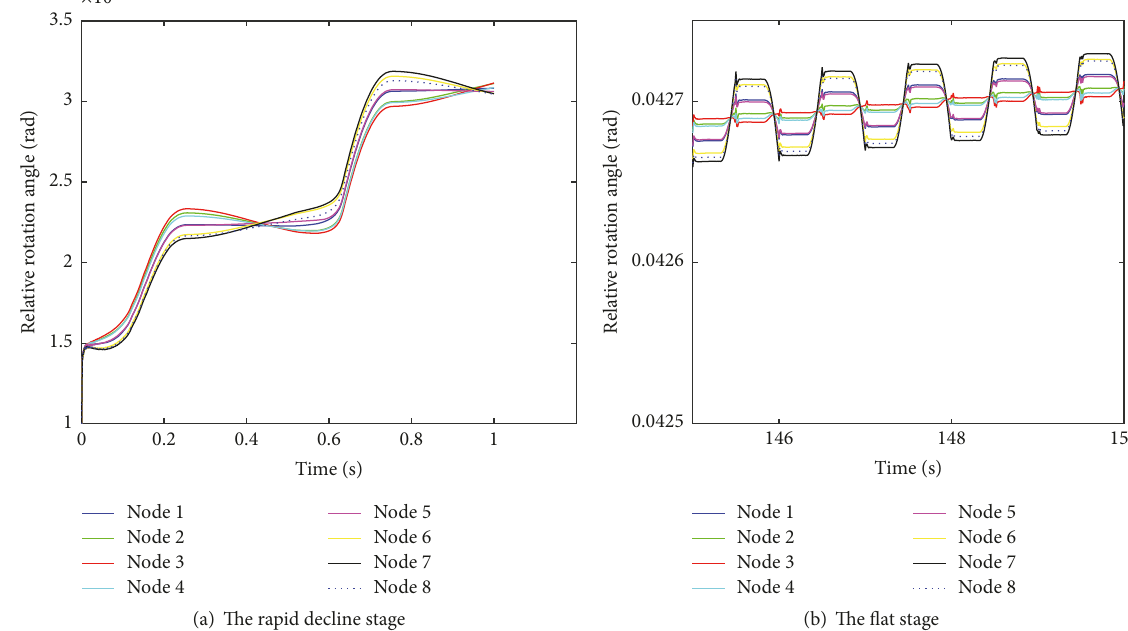
Figure 19: The rotation angles of each point in different